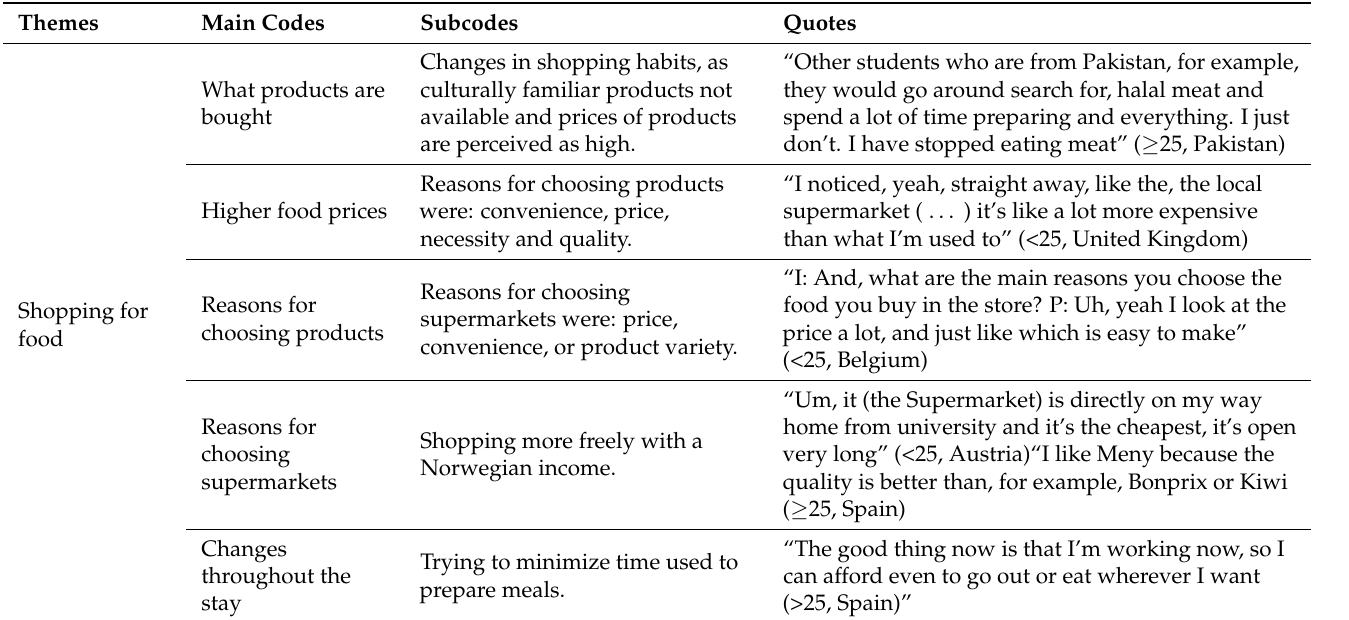
Table A4. Main themes and